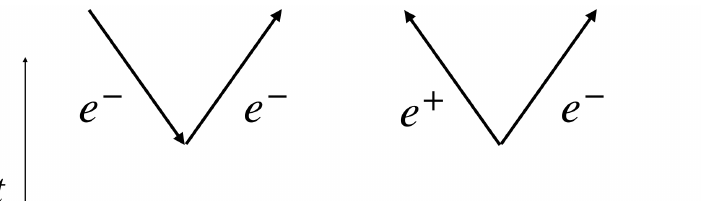
Figure 6. An electron–positron pair can equivalently be seen as either an electron propagating backwards in time, bouncing, and then propagating forward in time or as a particle–antiparticle pair propagating forward in